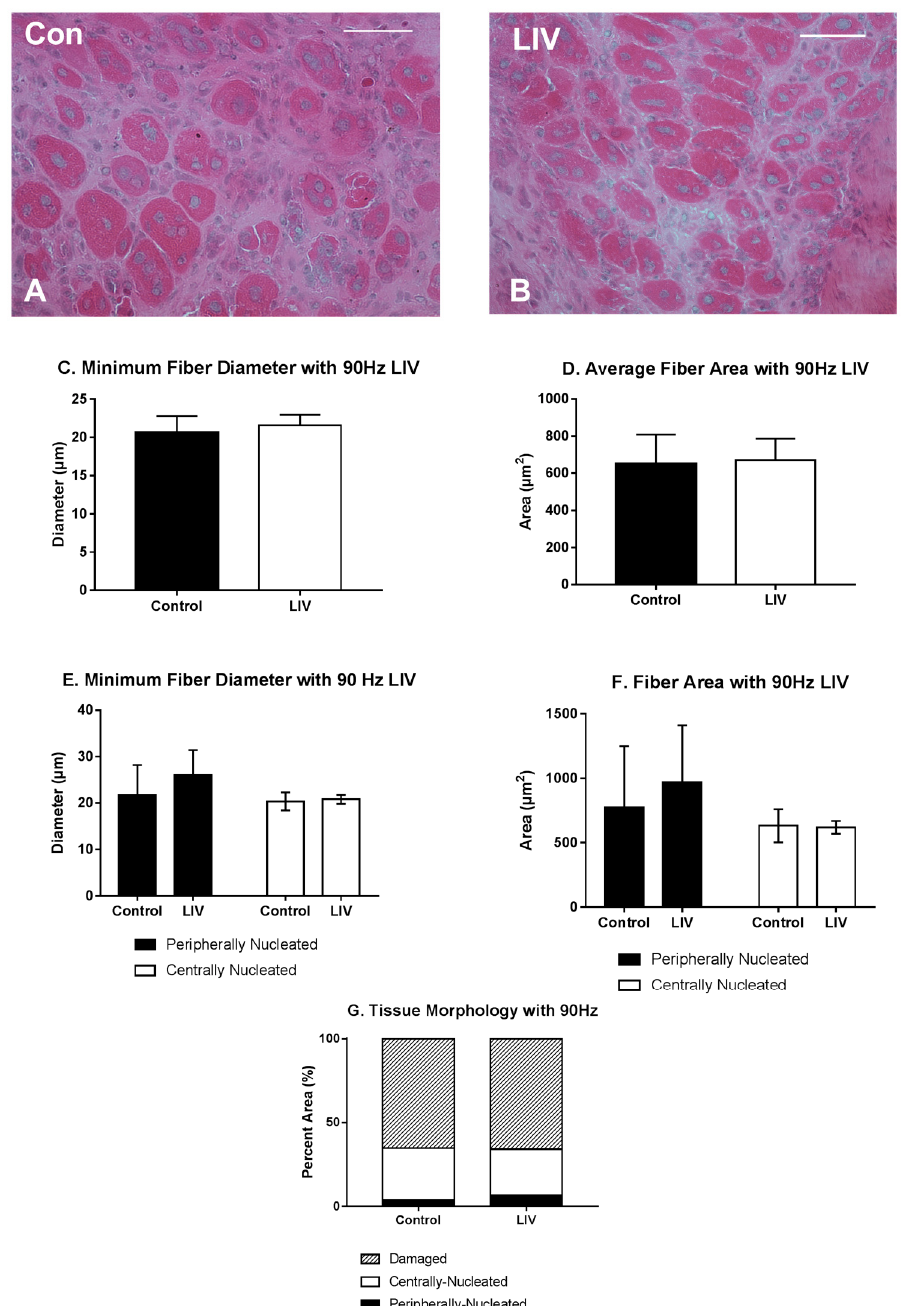
Figure 5. Low-intensity vibration (LIV) at 90 Hz and 0.2 g does not influence muscle regeneration on day seven post-injury following laceration muscle injury in mice. Gastrocnemius muscles were lacerated and collected for histological analysis at day seven post-injury. ( A , B ) Representative images of hematoxylin and eosin-stained sections (scale bar = 50 μ m, 40× magnification); ( C , E ) Average minimum myofiber diameter; ( D , F ) average cross-sectional area of individual myofibers, and ( G ) percent area of injury that consists of peripherally-nucleated fibers, centrally-nucleated fibers, or damaged tissue was quantified in five 40× fields per muscle in hematoxylin and eosin-stained sections; ( C , D ) All fiber types averaged together; ( E , F ) Myofibers grouped by type. Data are presented as mean ± SE.